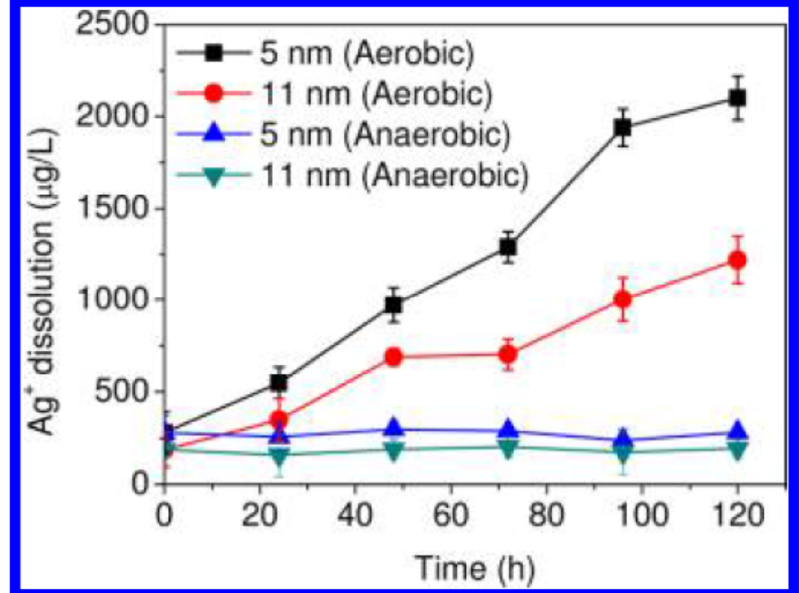
Figure 6. Dissolved Ag + concentration vs. air exposure time for PEG-AgNPs with sizes of 5 and 11 nm under aerobic conditions. No Ag + ions can be detected (<1 μg/L) under anaerobic conditions. Reproduced from [147] with permission of the American Chemical Society.